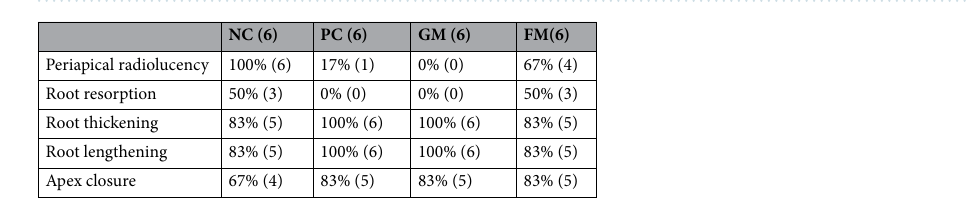
Table 2. Radiographic outcomes of the experimental groups after 12 weeks. NC negative control, PC positive control, GM gelatin-based matrix, FM fibrin-based